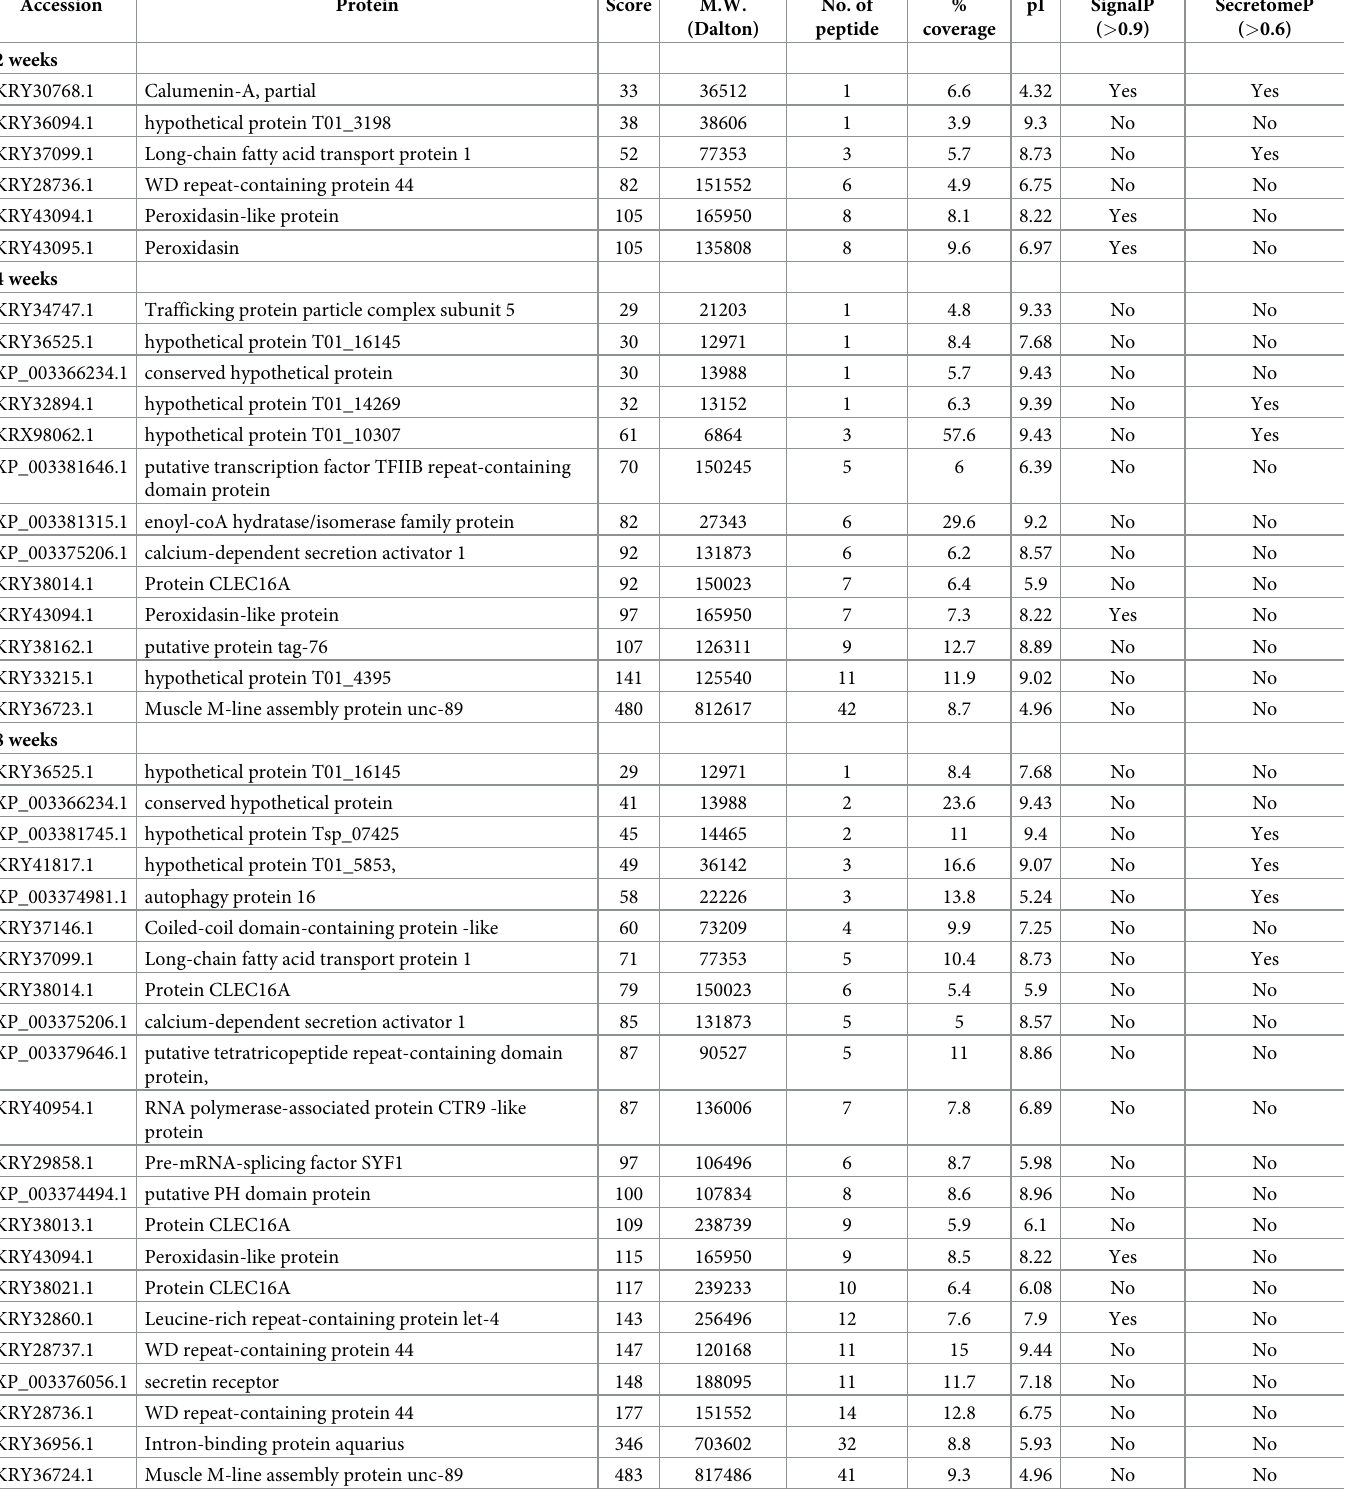
Table 2. Identification of T . spiralis circulatory proteins in mouse infected sera at 2, 4 and 8 weeks after T . spiralis infection using LC-MS/MS. The NCBI database was used with T . spiralis set as the taxonomy filter. The SignalP score greater than 0.9 and SecretomeP score greater than 0.6 were defined as classical and non-classical pro- tein secretion,